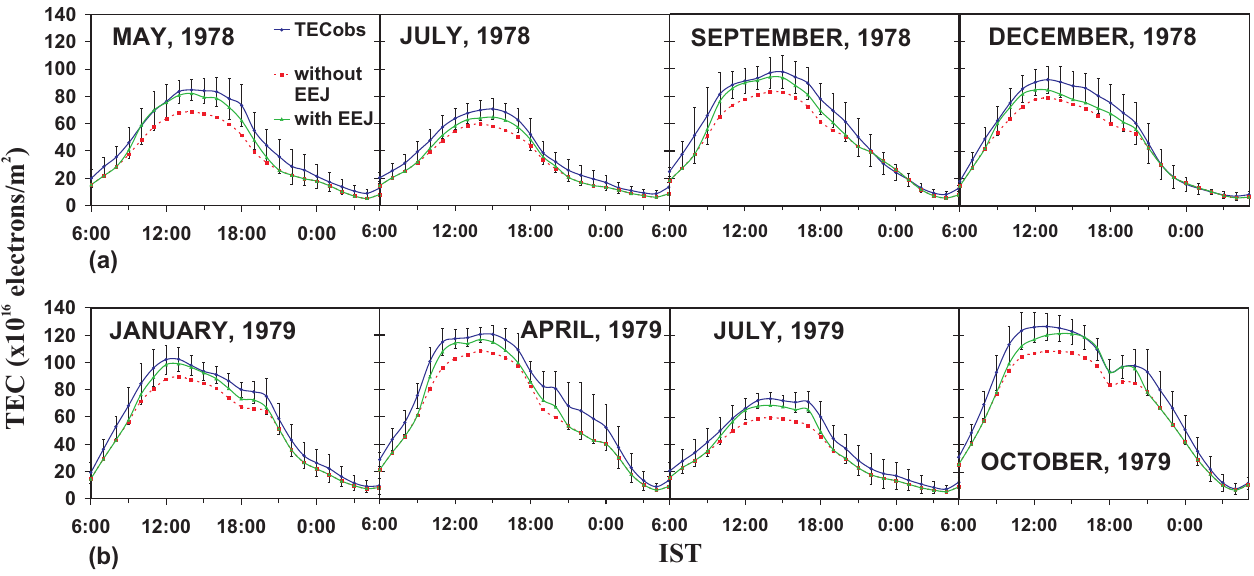
IST Figure. 7 Fig. 7. Plots of diurnal variation of monthly mean observed TEC (solid blue lines with vertical bars), estimated TEC with (solid green lines) and without (red dotted lines) EEJ contribution for various months of the years (a) 1978 and (b) 1979, respectively. For derivation of the empirical formula TEC data for the period 1980–1990 have been used. Vertical bars represent standard deviations of the monthly mean observed